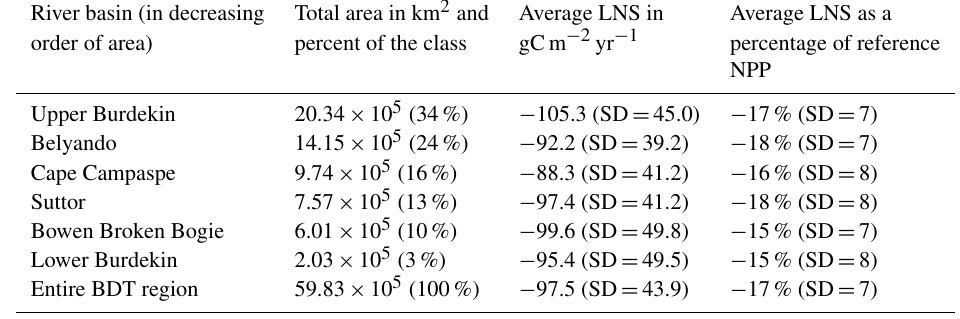
Table 5. Non-degraded LNS class. Area, severity, and variation in LNS and LNS percent. SD – standard deviation. River basin (in decreasing